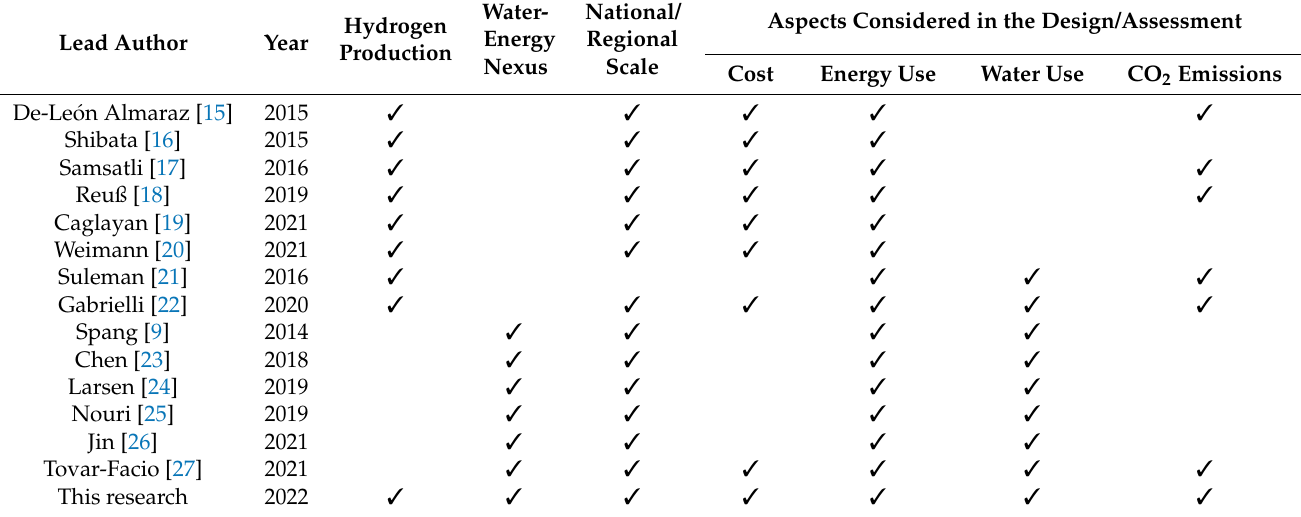
Table 1. Main characteristics of previous studies regarding the hydrogen supply chain and energy systems assessment considering the Water-Energy-Carbon nexus and